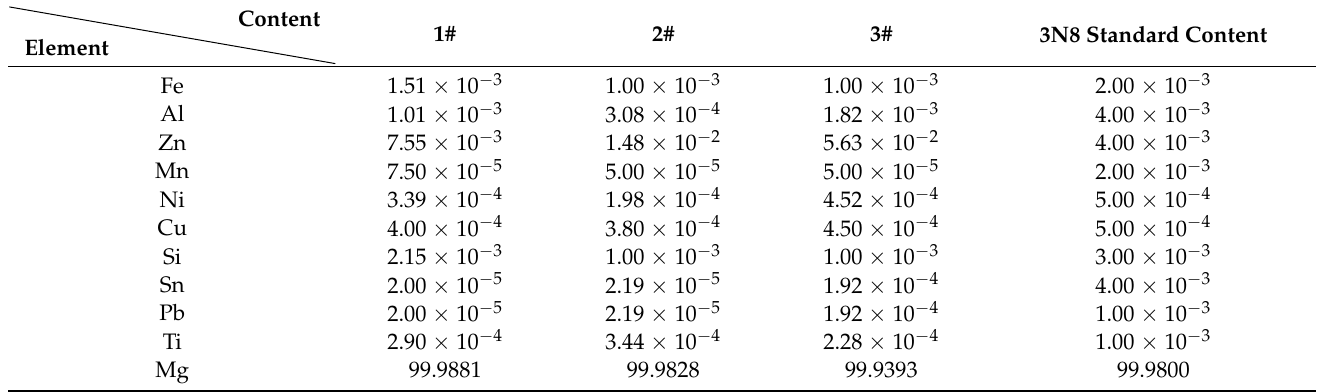
Figure 9. Contrast chart of the standard with the impurity compositions obtained after 30 min distillation at 1073 K and condensation at 873 K under vacuum (100 Pa). Table 3. Comparison of 3N8 national standard and graphite paper condensate purity (wt.%).